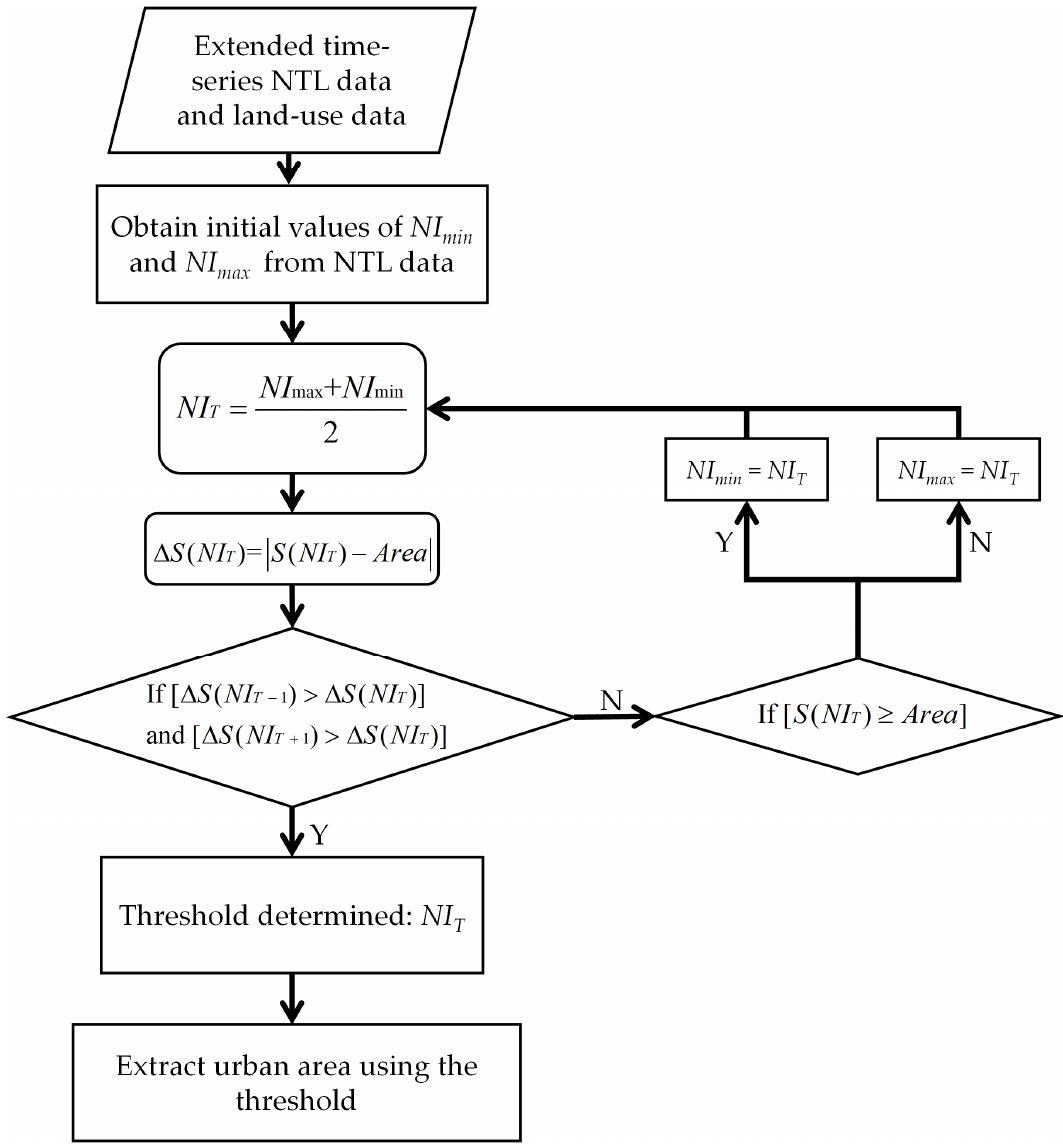
Figure 2. The flow chart for extracting urban areas by determining dynamic thresholds.